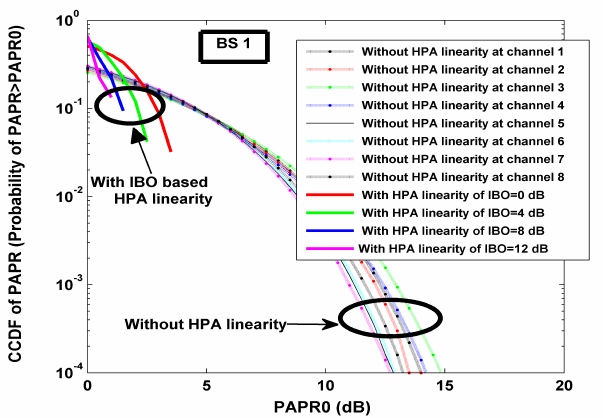
Figure 13. CCDFs of PAPR for the considered system with and without the utilization of an IBO − aided PAPR scheme at BS